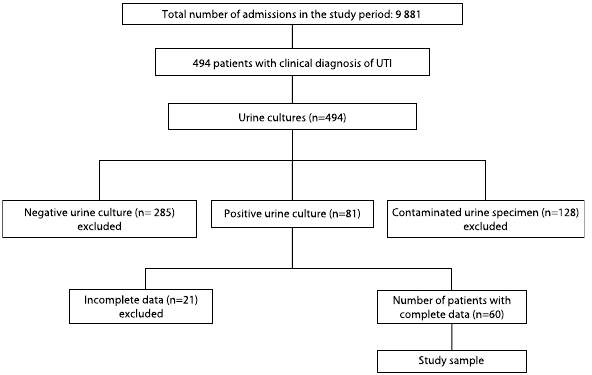
Figure 1: Study flow